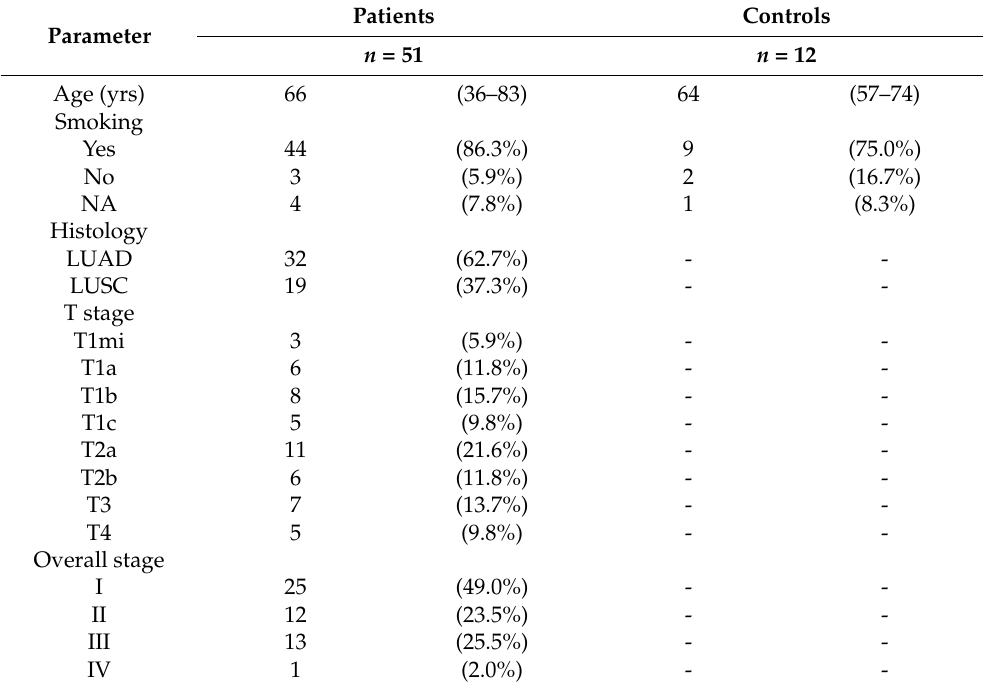
Table 1. Study population’s main clinical